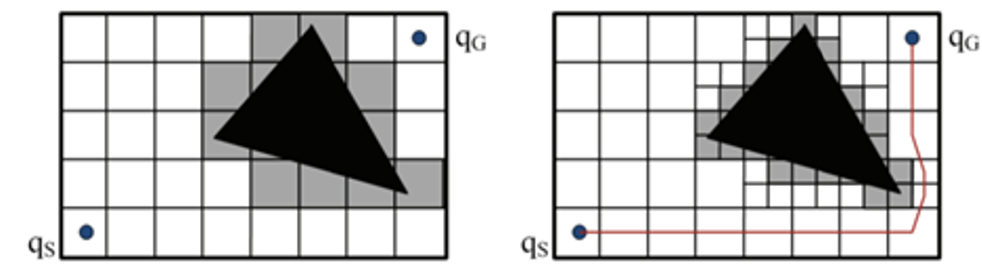
Figure 2. The effect of cell size in combinatorial planning when trying to reach q